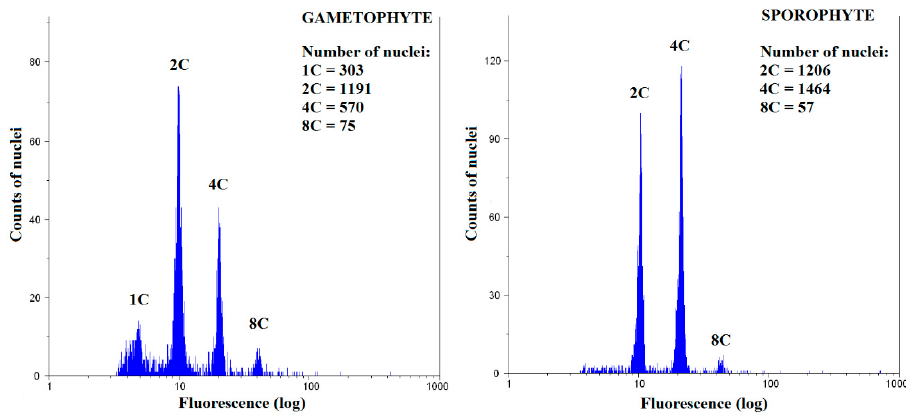
Figure 3. Representative flow cytometry histogram for Bryum moravicum gametophyte and sporophyte.